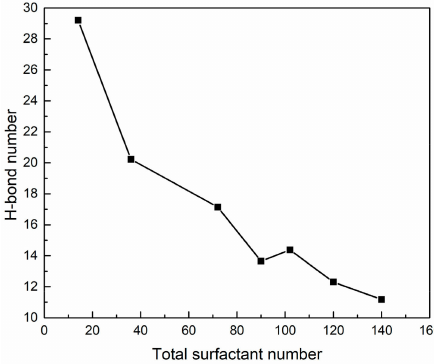
Figure 17. Hydrogen bond numbers between PVA and water molecules in SDE 3 S / PVA